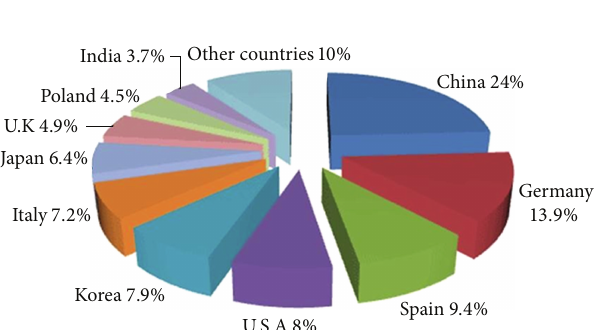
Figure 9: Proportion of Taiwan solar photovoltaic export. Source: Directorate General of Customs (2010)